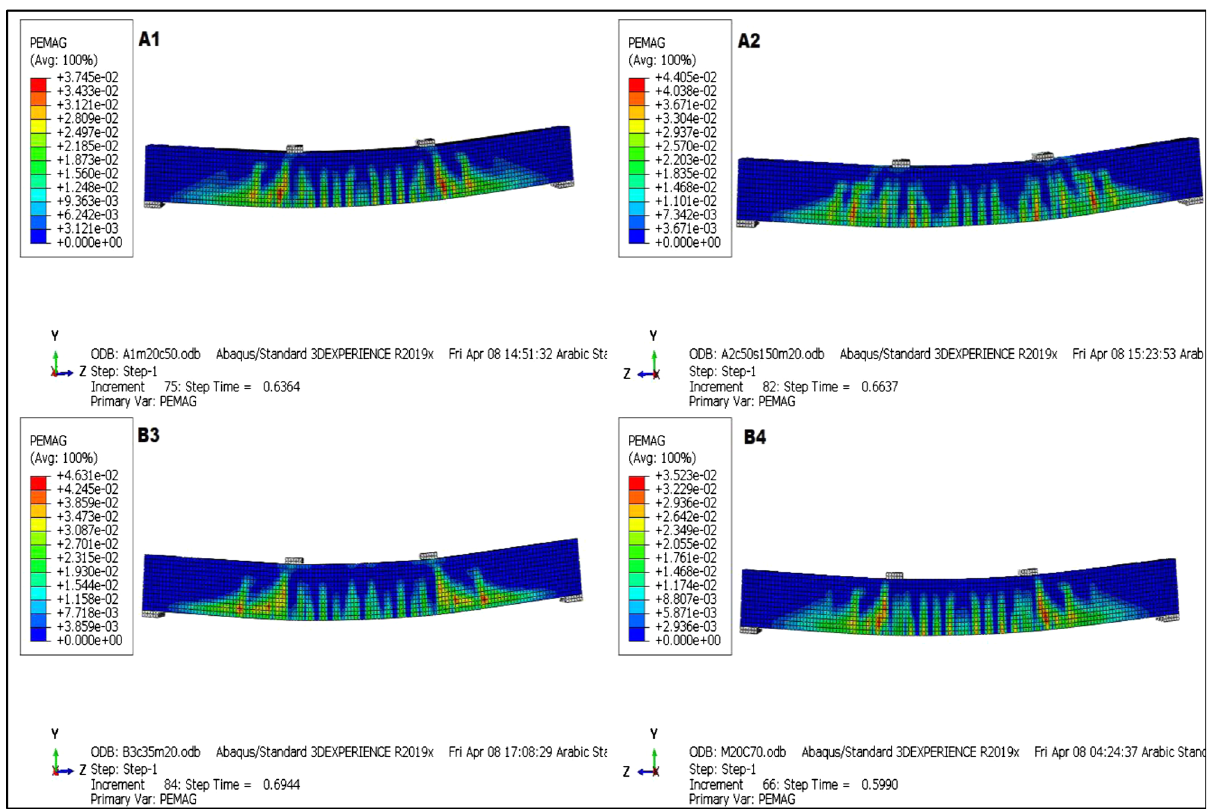
Figure 17: Cracks ’ pattern.